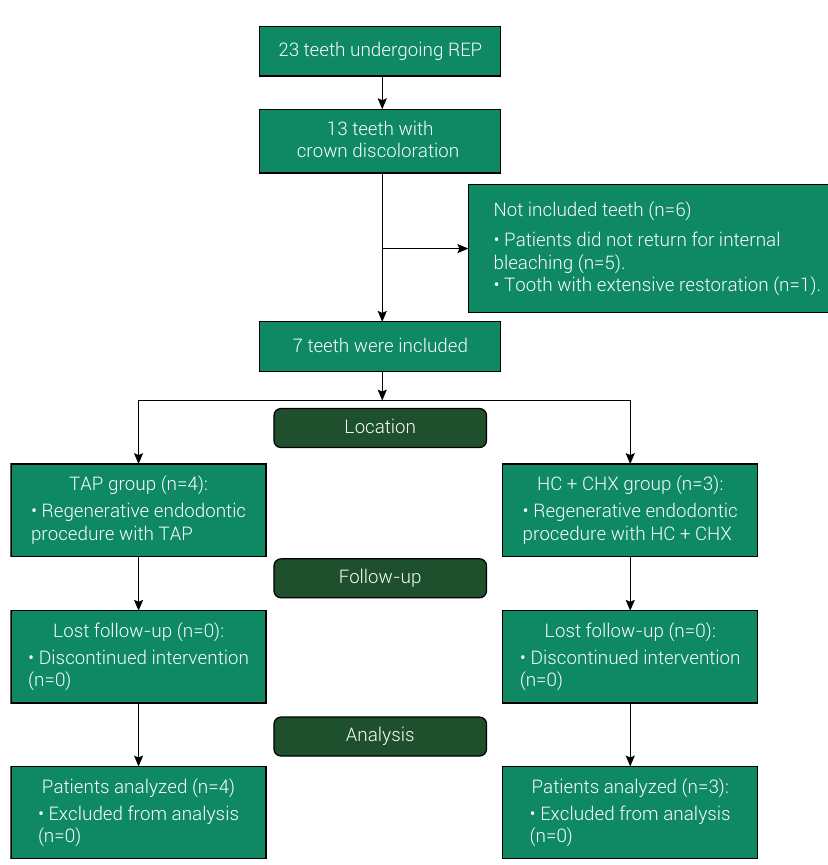
Figure 2. Flowchart of the distribution of the teeth included in the